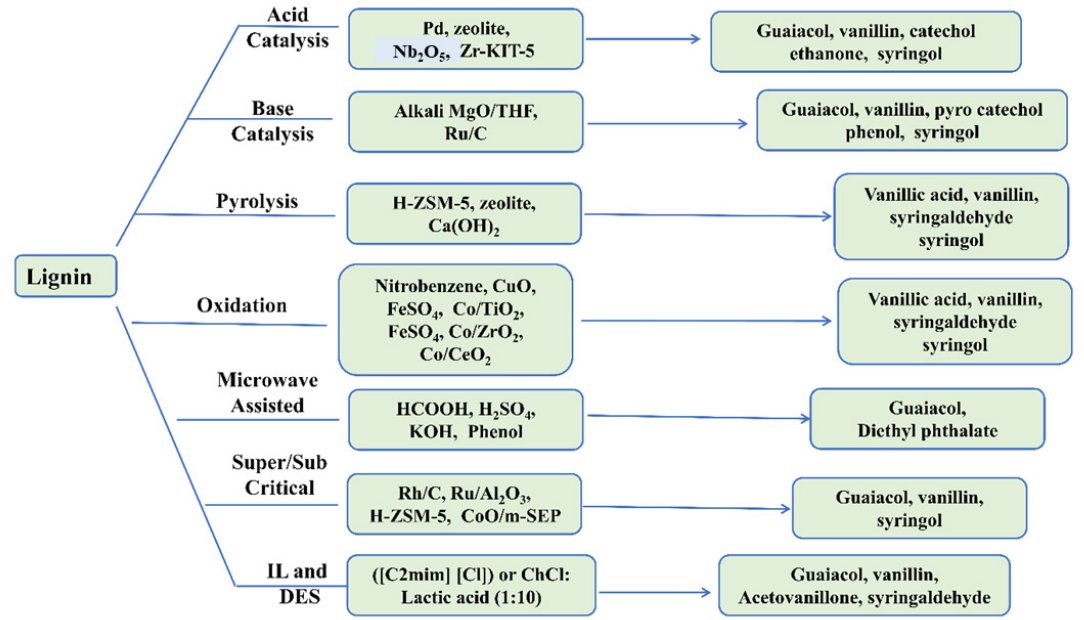
Figure 5. Schematic diagram of different depolymerization